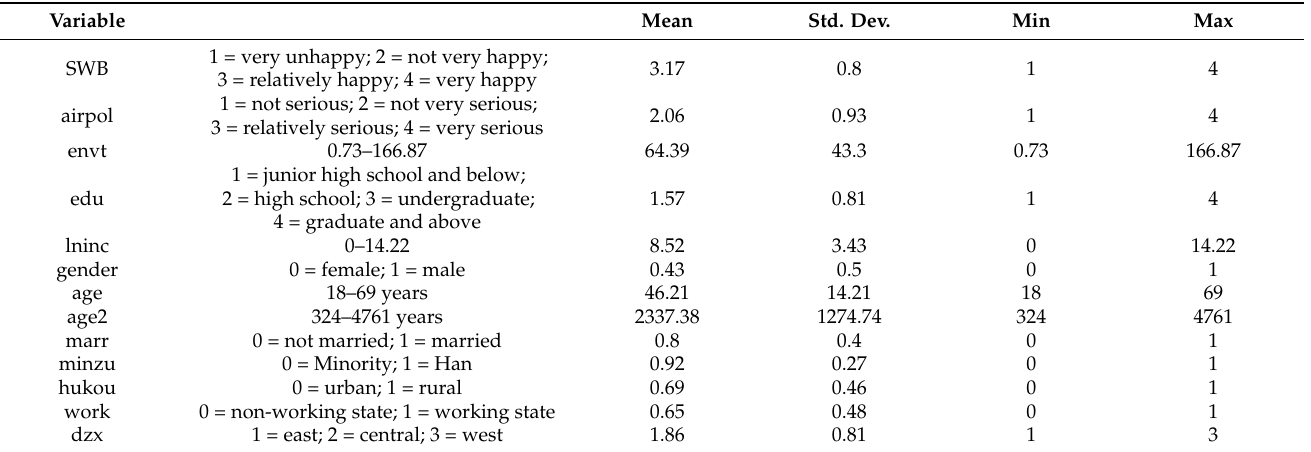
Table 1. Descriptive statistical analysis of